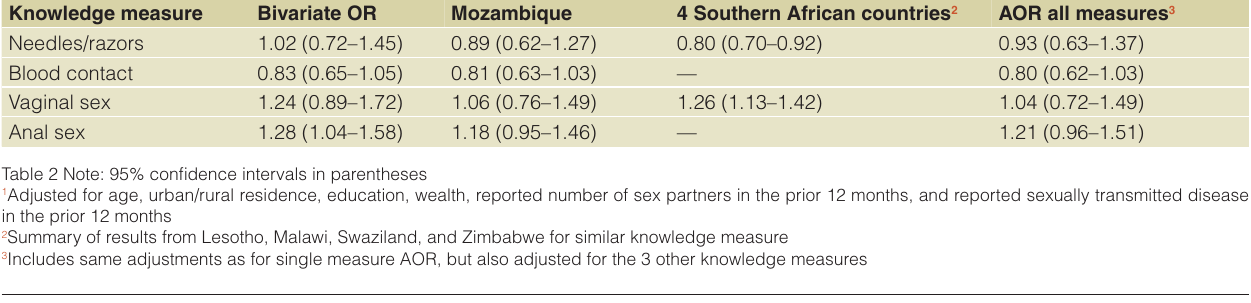
Knowledge measure